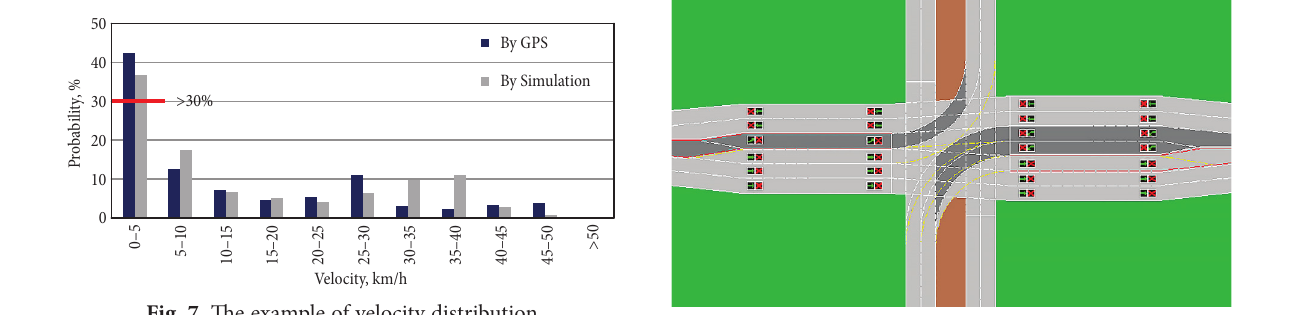
Fig. 9. The afternoon arrangement (source: own